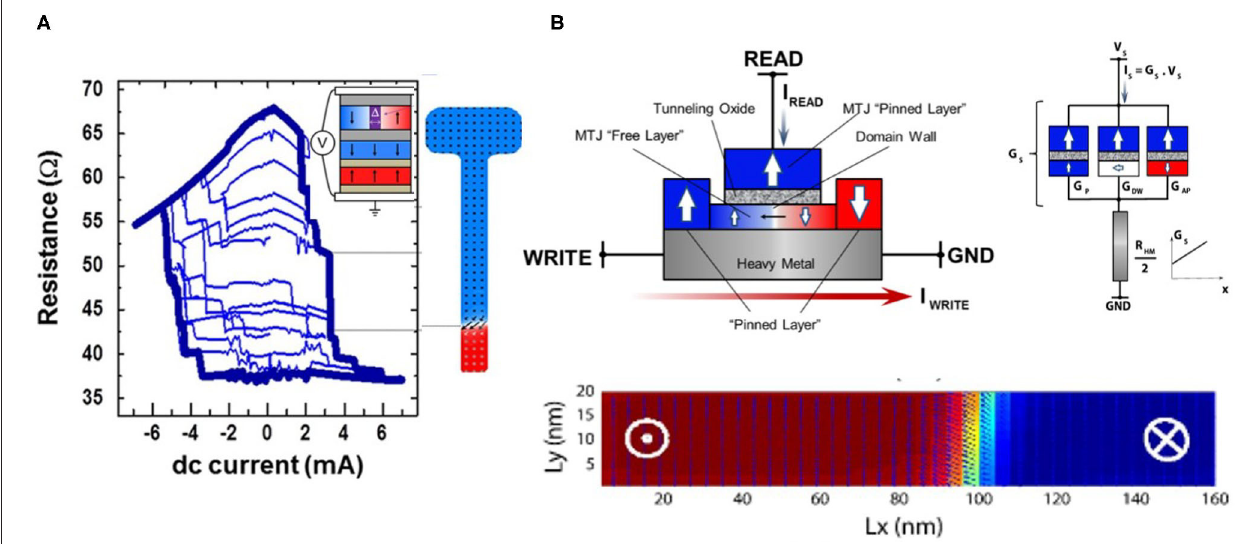
FIGURE 3 | Domain wall motion (DWM) based multi-level devices. (A) STT-driven DWM in a MTJ-based device. Lequeux et al. Scientific Reports 6, 31510 (2016), Copyright 2016 Author(s), licensed under a Creative Commons Attribution (CC BY) license. (B) SOT-driven DWM device. Dzyaloshinskii-Moriya exchange interaction across the heavy metal and ferromagnetic layer provides effective magnetic fields that ensure deterministic switching. Reproduced with permission from Sengupta et al. IEEE Transactions on Biomedical Circuits and Systems, 10, 1152–1160 (2016), Copyright 2016